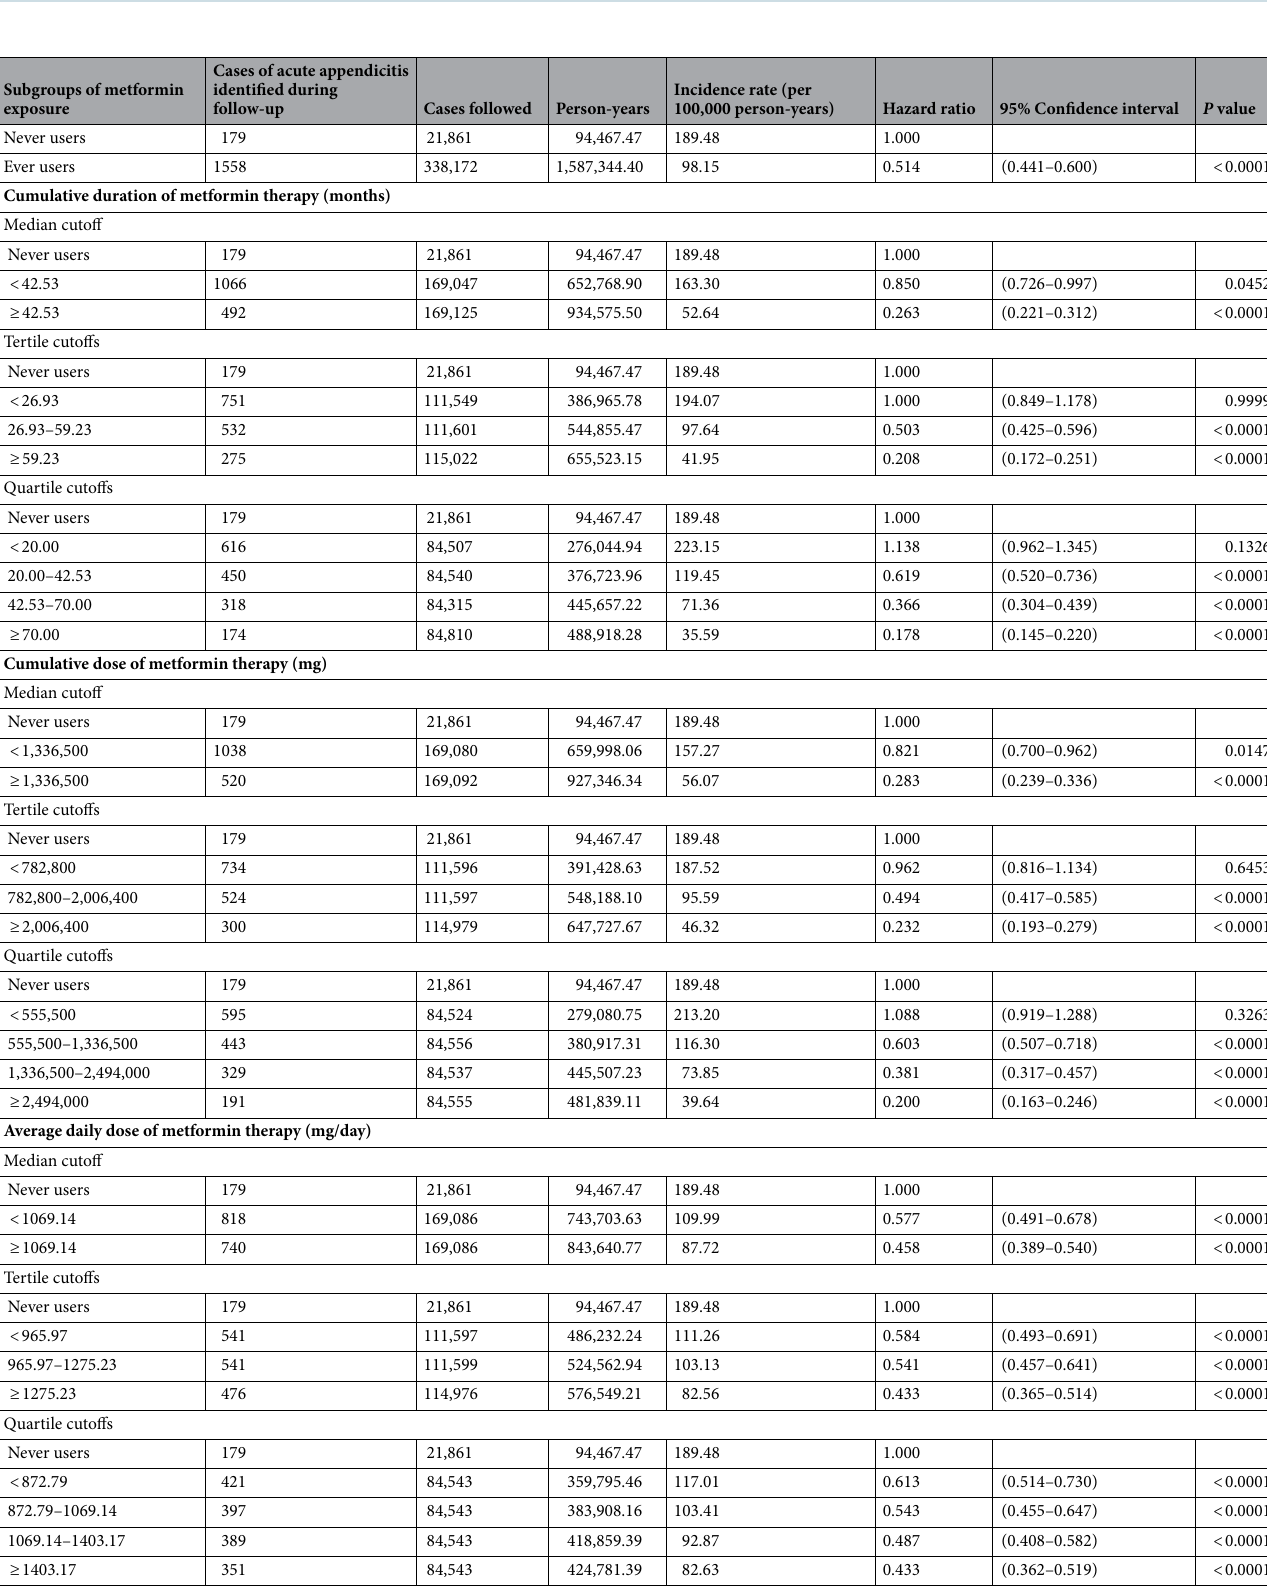
Table 2. Incidence rates of acute appendicitis in different subgroups of metformin exposure and hazard ratios comparing different subgroups of metformin users versus metformin never